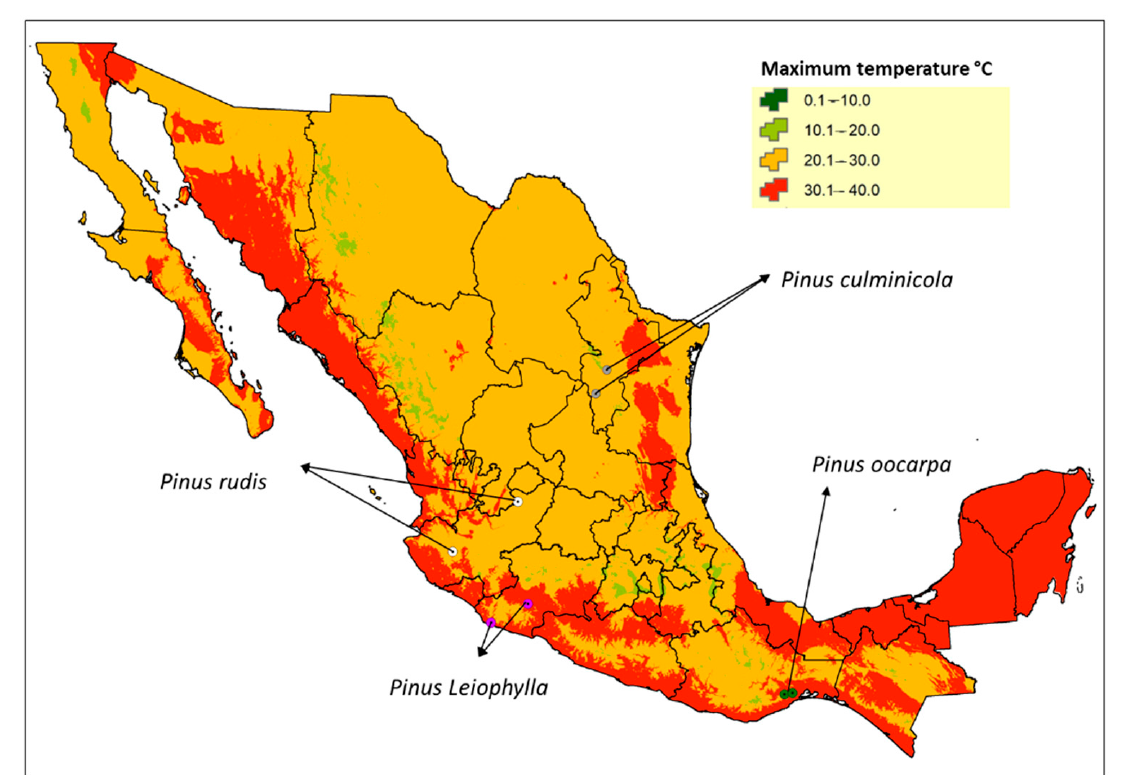
Figure 2. Geographical location of the four pine species in the monthly maximum average temperature models. Source: National Weather Service (SMN) daily weather base 1902–2011. (http://atlasclimatico.unam.mx/atlas/kml/ (accessed on 22 May 2019)). Table 3. Collection locations for seeds from populations of the genus Pinus .